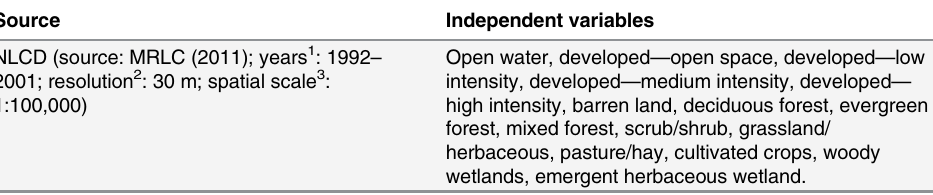
Table 1. Physical environment variables screened in the study.